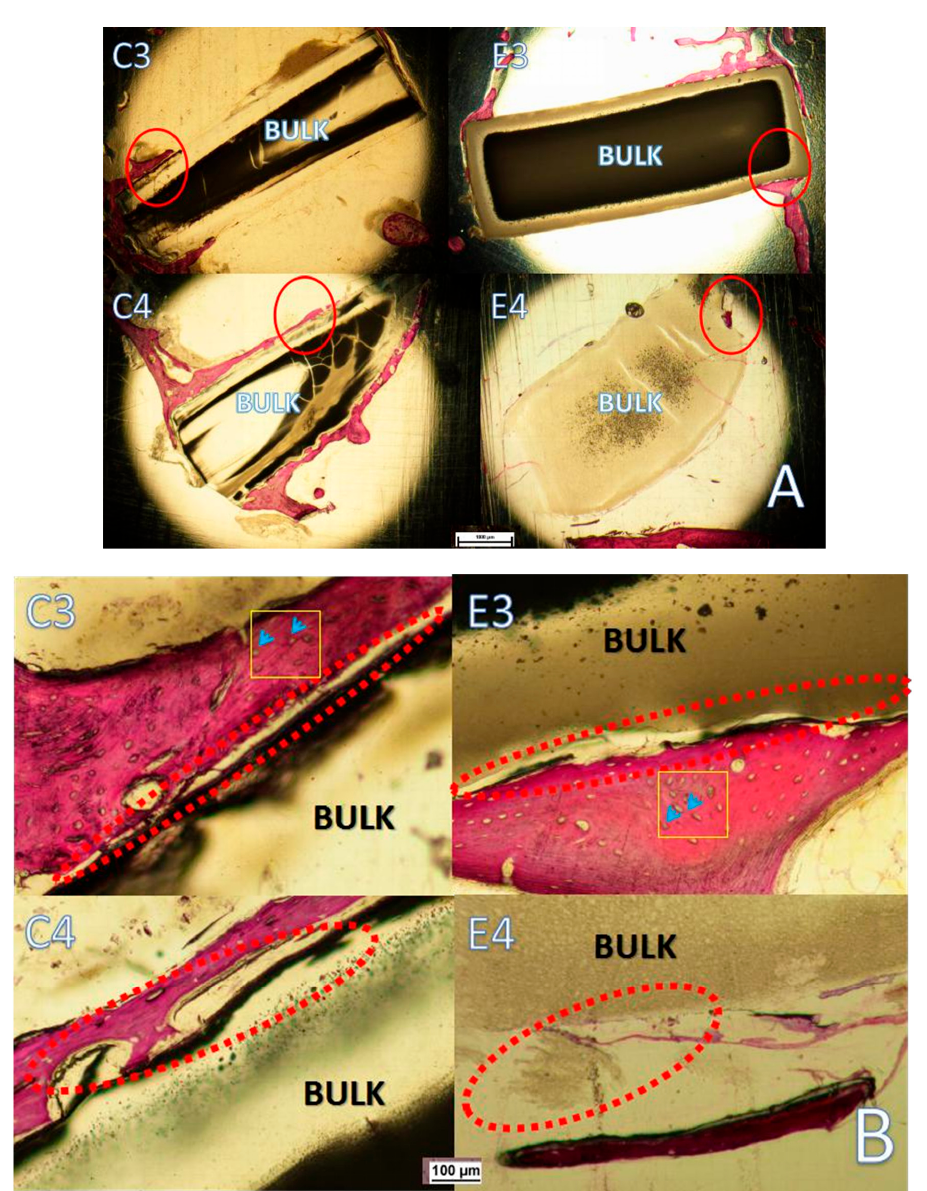
Figure 13. Histological morphologies of implanted PLLA and PLLA1 after 3 and 6-month durations of implantation: ( A ) The whole samples; ( B ) the partial enlargement; the blue arrow indicates the bone cell.